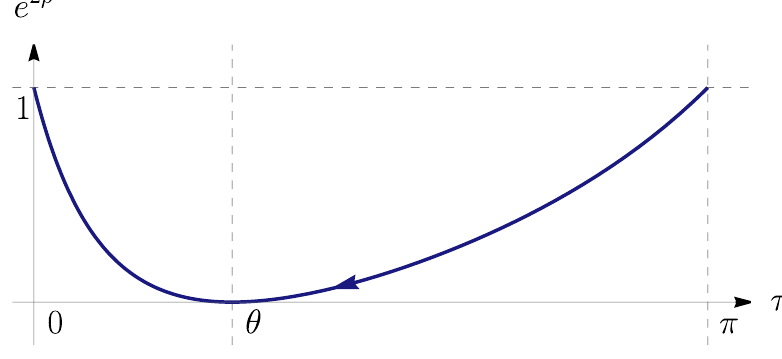
as τ is decreased from π down to 0 at fixed θ . ¯ z